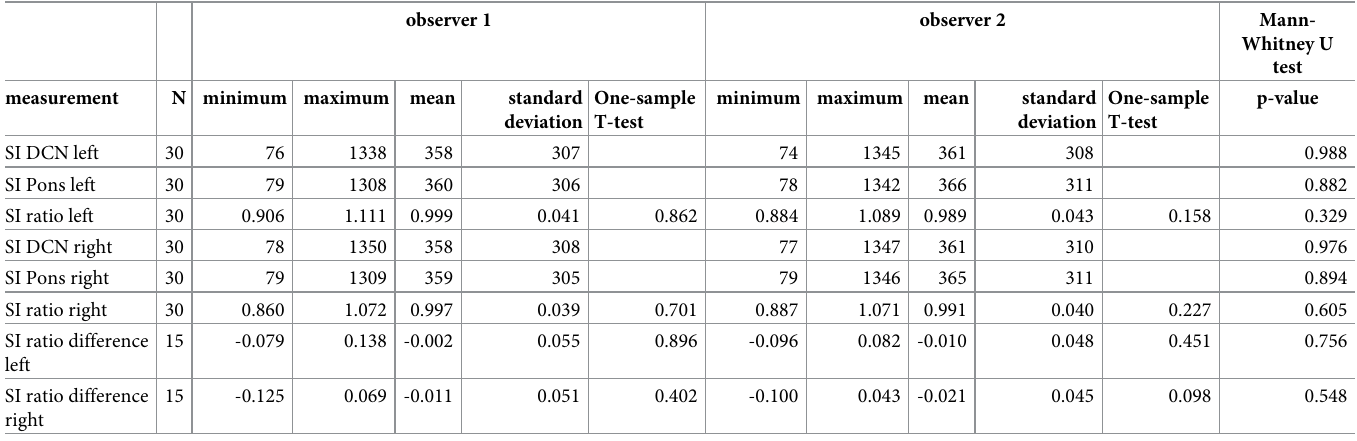
Table 3. Measurement